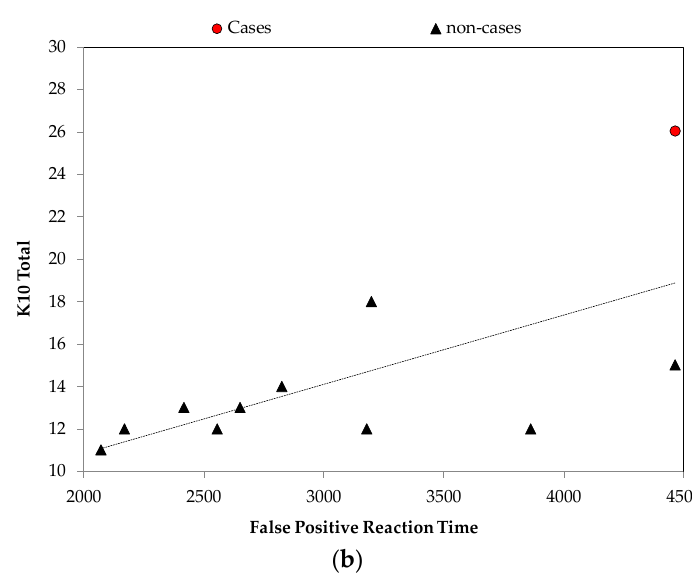
Figure 1. Angry Faces: scatter plots showing that ( a ) higher levels of psychological symptoms (SPHERE-12 PSYCH) are associated with fewer correct identifications of angry faces (r = − 0.32) and that ( b ) higher levels of psychological distress (K10) are associated with slower reaction times for false positive for angry faces (r = 0.68 bottom panel).